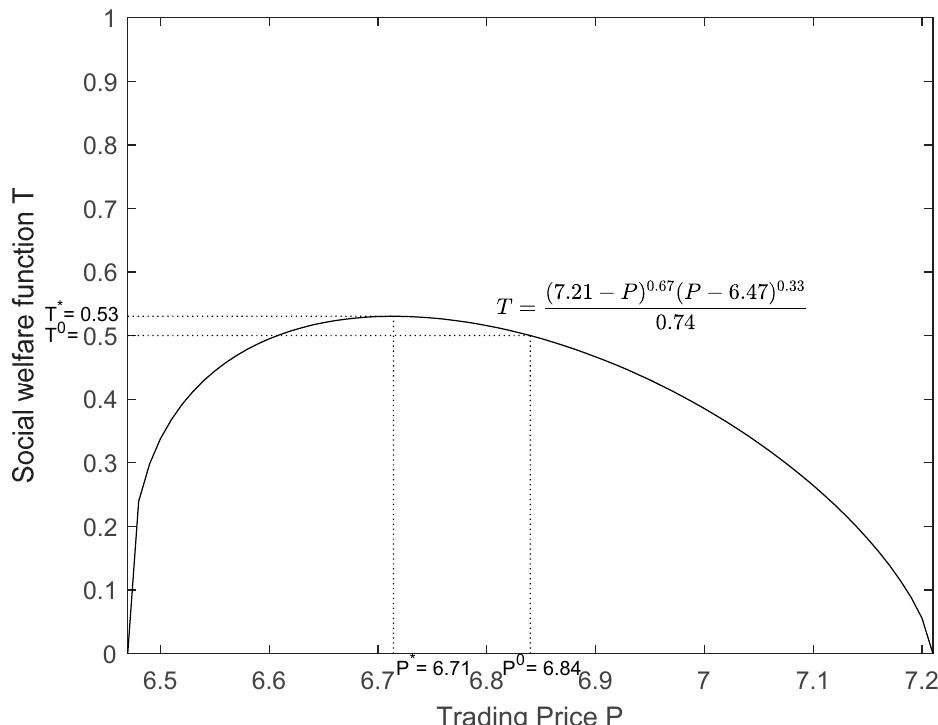
Figure 2. Schematic diagram of the optimal transaction price.